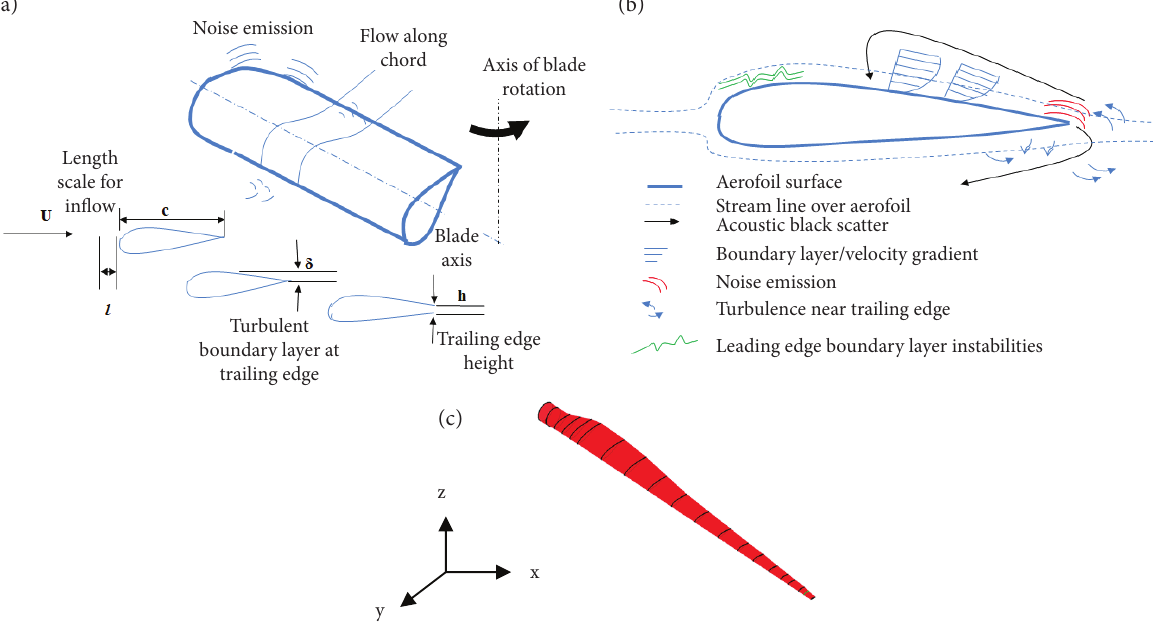
2012); (b) noise generation mechanism near the trailing edge of aerofoil; (c) illustration of a 37 m turbine blade developed using NuMAD